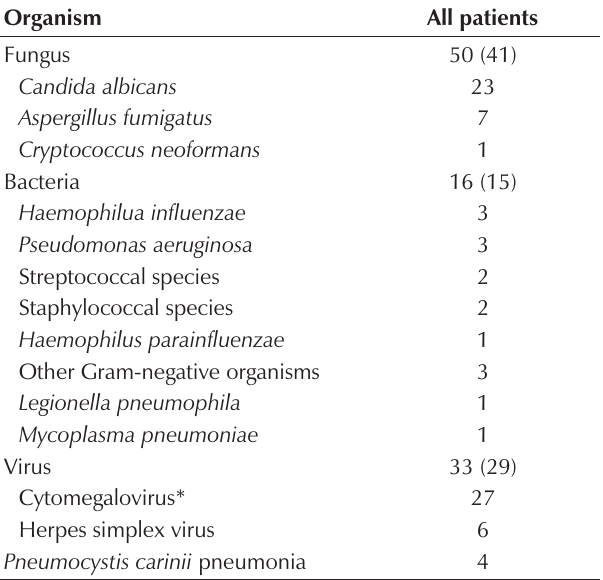
Organisms identified in bronchoalveolar lavage in patients with underlying malignancy Organism All patients